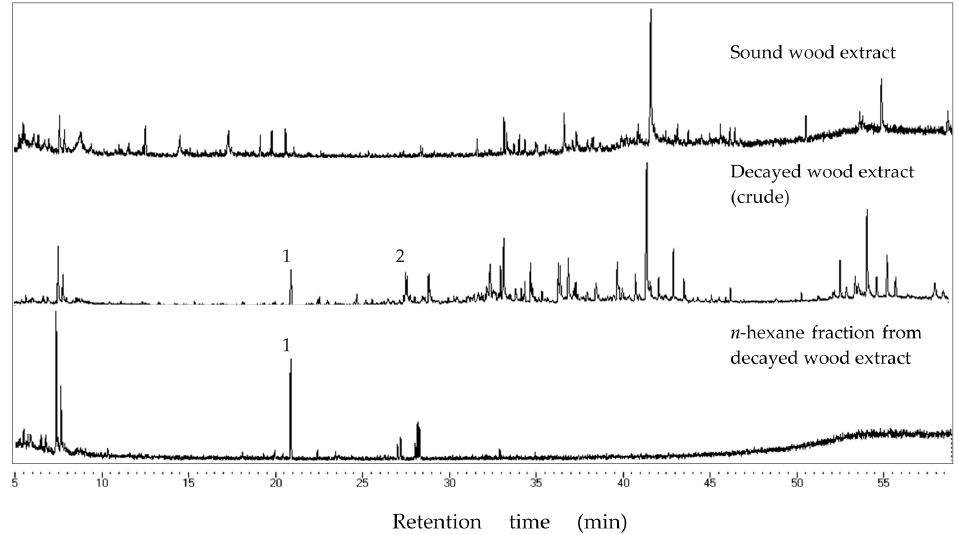
Figure 3. Chromatogram of extracts from sound wood, crude decayed wood, and the n- hexane fraction from decayed wood extract. Peak 1 (retention time (RT) 21.11) eluted in the n- hexane fraction after chromatography.